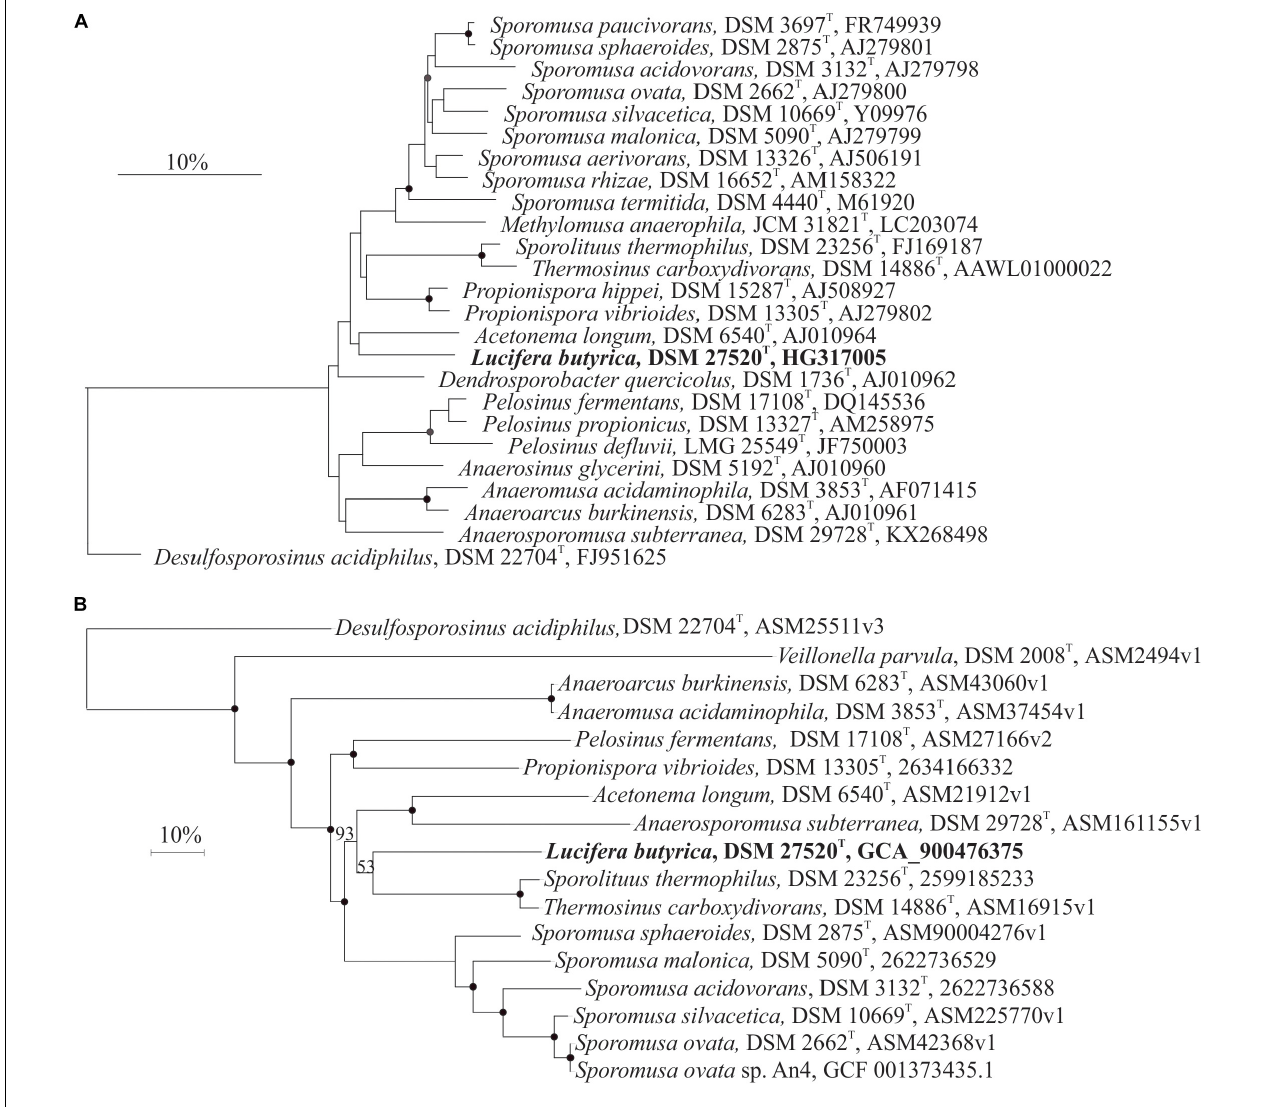
FIGURE 1 | (A) 16S rRNA gene sequence phylogenetic reconstruction of strain ALE T (bold type) and of related species in the Sporomusaceae family of the Firmicutes phylum. Consensus tree was performed after applying the maximum likelihood, neighbor-joining and maximum parsimony algorithms implemented in the ARB package. Trees were constructed with different filters (termini, subact, none) and based on 1000 replications. Bootstrap values greater than 70% are indicated by filled circles, and greater than 50% by gray circles. Bar indicates a 10% estimated sequence divergence. The sequence of Desulfosporosinus acidiphilus was used as outgroup. (B) Phylogenetic reconstruction with maximum-likehood of the core genes from 28 sequenced species closely related to Lucifera butyrica strain ALE T . Bootstrap of 100% are indicated by filled circles, and others by their number for clarity. Bar indicates a 10% estimated sequence divergence. The sequence of Desulfosporosinus acidiphilus was used as